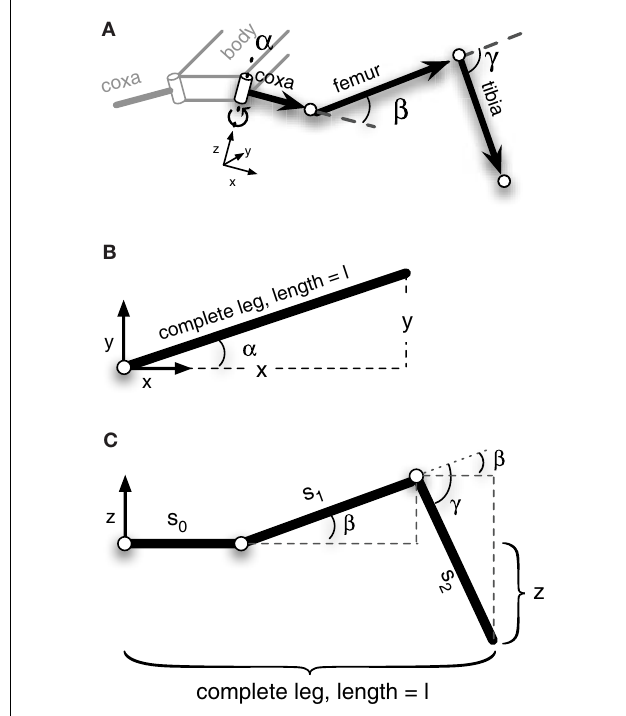
FIGURE 3 | Schematic figure of the left front leg of a stick insect. The leg consists of three hinge joints. (A) Shows a view of the complete leg attached to the body. (B) Top view of the leg.The α -joint moves the leg forward and backward. In (C) the leg is seen from the front. β - and γ -joint operate on a plane, meaning their axes are parallel to each other and are perpendicular to the leg plane. Lifting the leg equals a positive movement in the β -joint, and an outward going movement produced by the γ -joint is defined as a positive movement.The origins of the joint coordinate systems are set corresponding to leg positions in a standing walker ( α is in a middle position, while β - and γ -joints are in a position in which the femur is approximately parallel to the ground and the tibia is nearly orthogonal to the